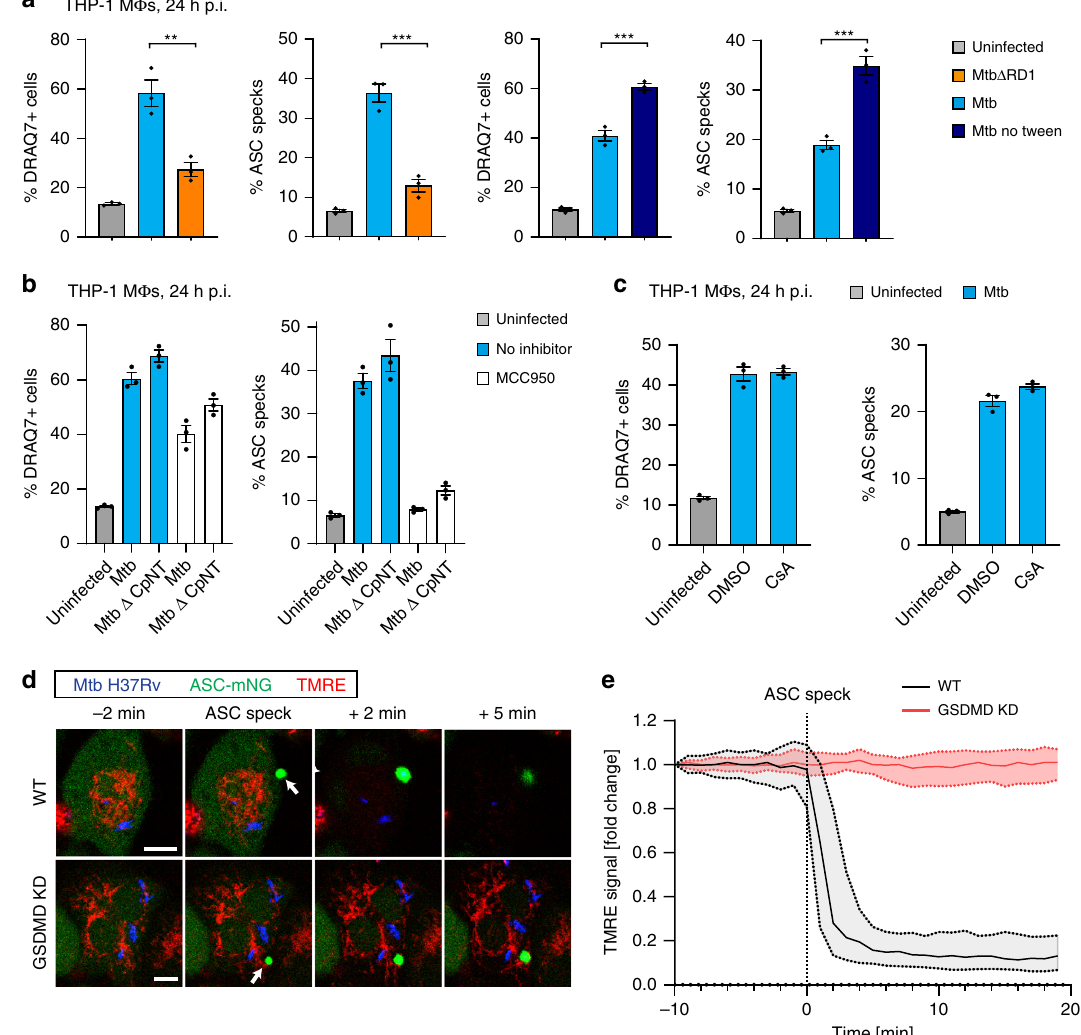
Fig. 3 Mtb-induced in fl ammasome activation depends on ESX-1 but not mitochondrial damage. In a – c , cells were fi xed and imaged by confocal microscopy at 24 h p.i. a To assess the role of ESX-1 and its secreted substrates in the Mtb capsule, THP1-ASC-GFP macrophages were infected with Mtb Δ RD1 or Mtb cultured in the presence or absence of tween-80. b THP1-ASC-GFP cells were treated or not with MCC950 (as indicated), and infected with Mtb or Mtb devoid of the channel protein with necrosis-inducing toxin (Mtb Δ cpnT ). c THP1-ASC-GFP cells were treated with DMSO or the inhibitor of the mitochondrial permeability transition pore, cyclosporine A (CsA), and infected by Mtb. In a – c , ASC specks and DRAQ7 + cells were quanti fi ed for n > 2000 cells per condition, * p < 0.05, ** p < 0.01, *** p < 0.001, by one-way ANOVA with two-sided Dunnett ’ s test. Bars show mean ± s.e.m. Data representative of three independent experiments. d Representative time-lapse images of Mtb-BFP-infected THP1-ASC-mNeonGreen cells or THP1-ASC- mNeonGreen GSDMD KD cells, with mitochondria stained by TMRE (red). TMRE accumulates in the mitochondria in proportion to the mitochondrial membrane potential ( ΔΨ m ), indicative of mitochondrial stability. Arrows indicate ASC specks. Scale bars 10 µ m. Data representative of three independent experiments. e Quanti fi cation of TMRE intensity before and after ASC-speck formation in WT and GSDMD KD cells ( n = 57 and n = 81 cells). Median ± IQR are shown. Data representative of two independent experiments. Source data are provided as a Source Data fi